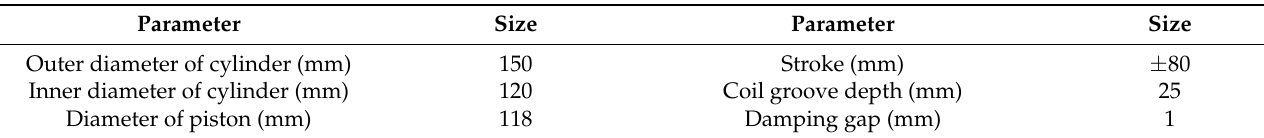
Figure 1. Structure schematic diagram of the MRD (mm). Table 1. The structure parameters of the MRD.